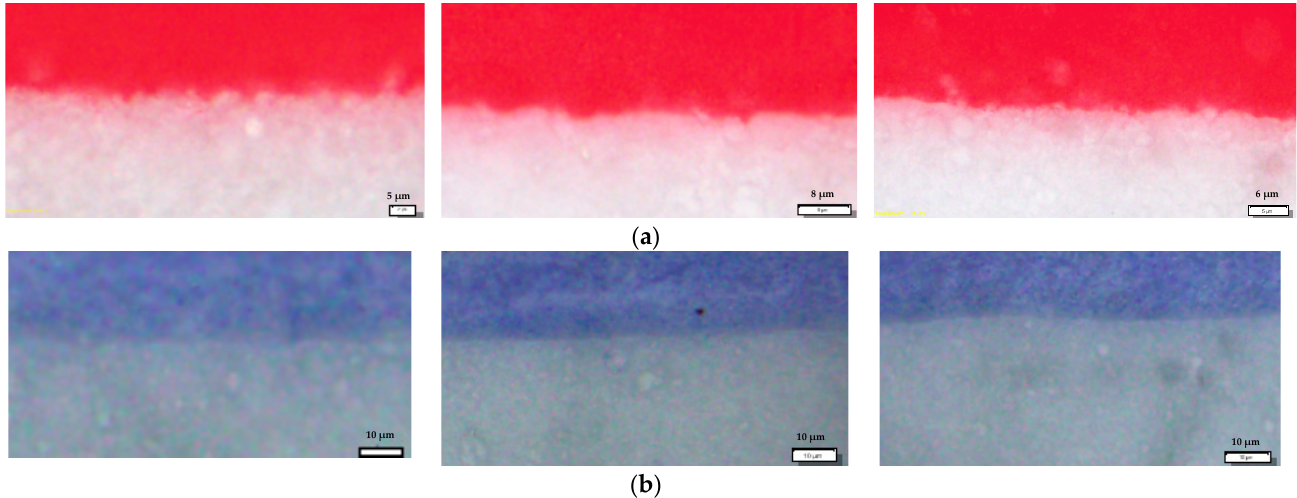
Table 2. Average edge raggedness and blurriness values for the thermochromic horizontal edge (TC-H), conventional horizontal edge (C-H), thermochromic vertical edge (TC-V), and conventional vertical edge (C-V). Figure 3. Horizontal edge profiles: ( a ) conventional ink; ( b ) thermochromic ink Leading edge blurriness varies significantly for horizontal and vertical edges